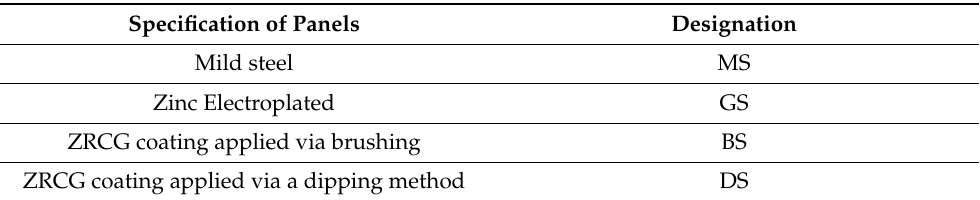
Table 1. Designation of the uncoated steel and coated